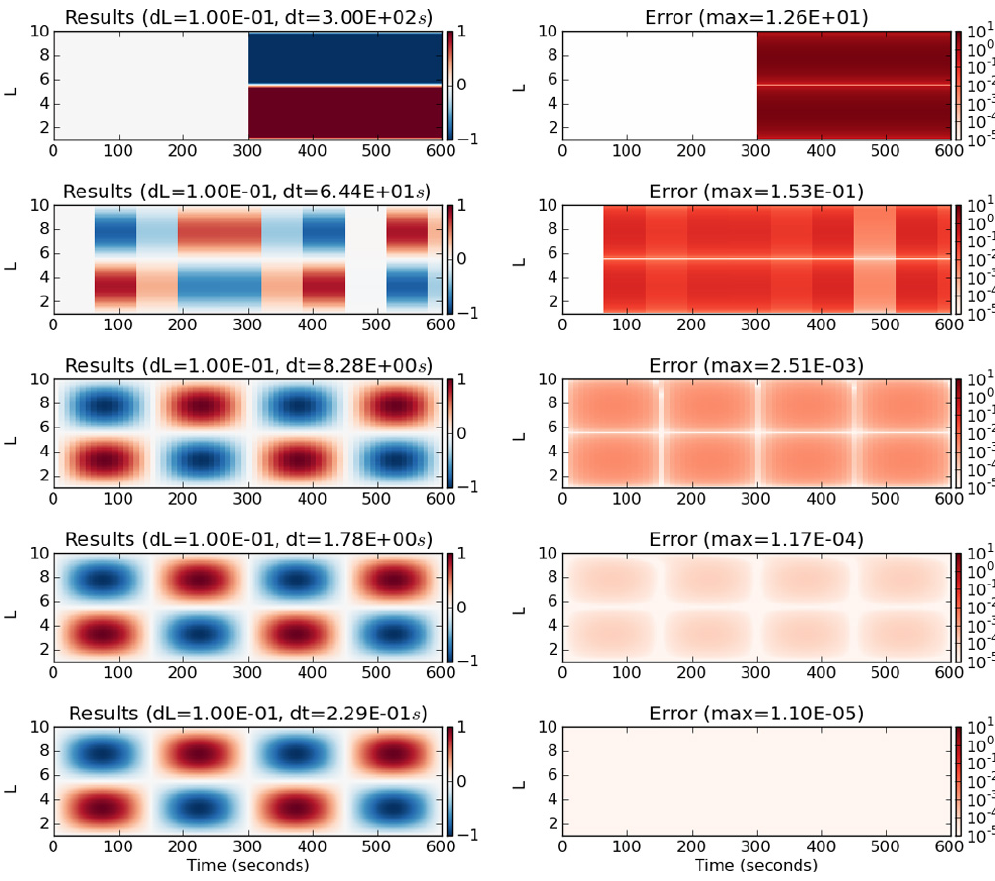
Fig. 4. A demonstration of the code converging towards the analytical solution as the time step is refined. The left column shows the numerical solution while the right column shows the corresponding error. Because the maximum error, listed in the title of each plot, reduces as the square of the time step, this figure hints at the expected convergence rate given the numerical scheme